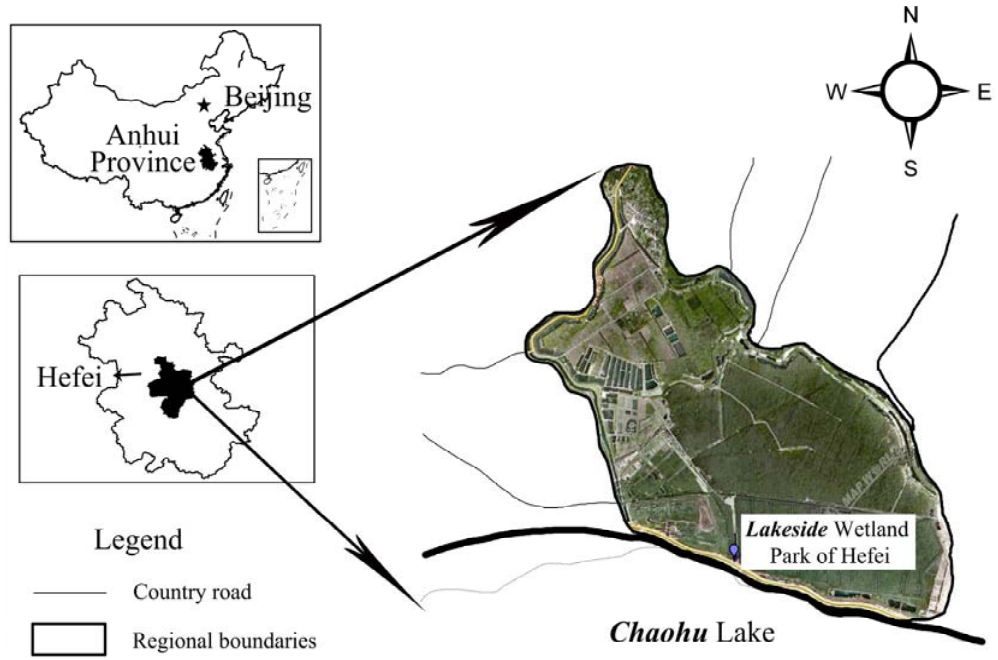
Figure 4. The geographic location of Lakeside Wetland Park.